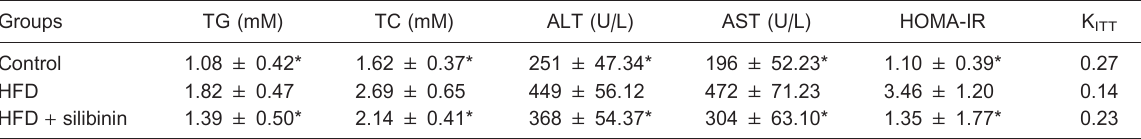
Table 3. Serum fat, hepatic enzymes and HOMA-IR of the rats in each group. Groups